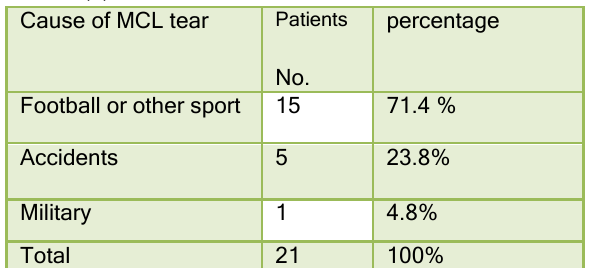
Table (3): Causes of MCL